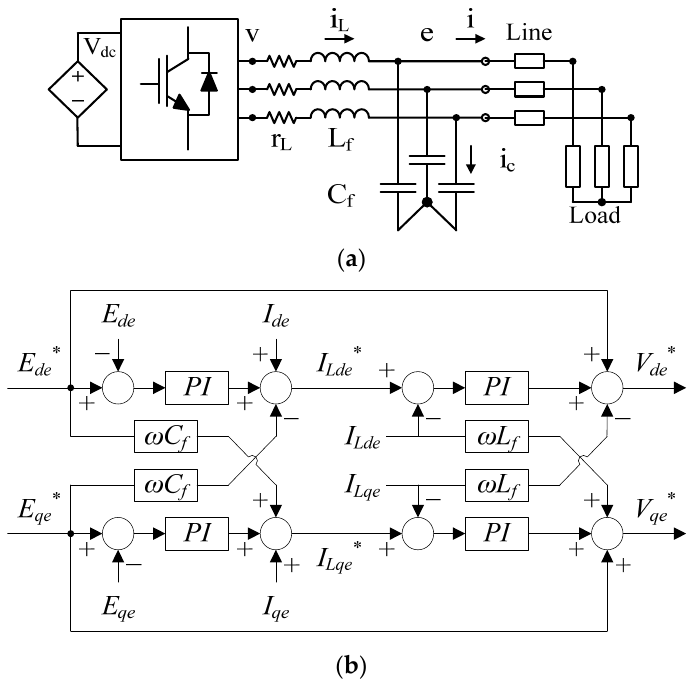
Figure 10. Voltage source converter and its voltage control. ( a ) Equivalent circuit for 3 ‐ phase inverter; ( b ) Output voltage control.